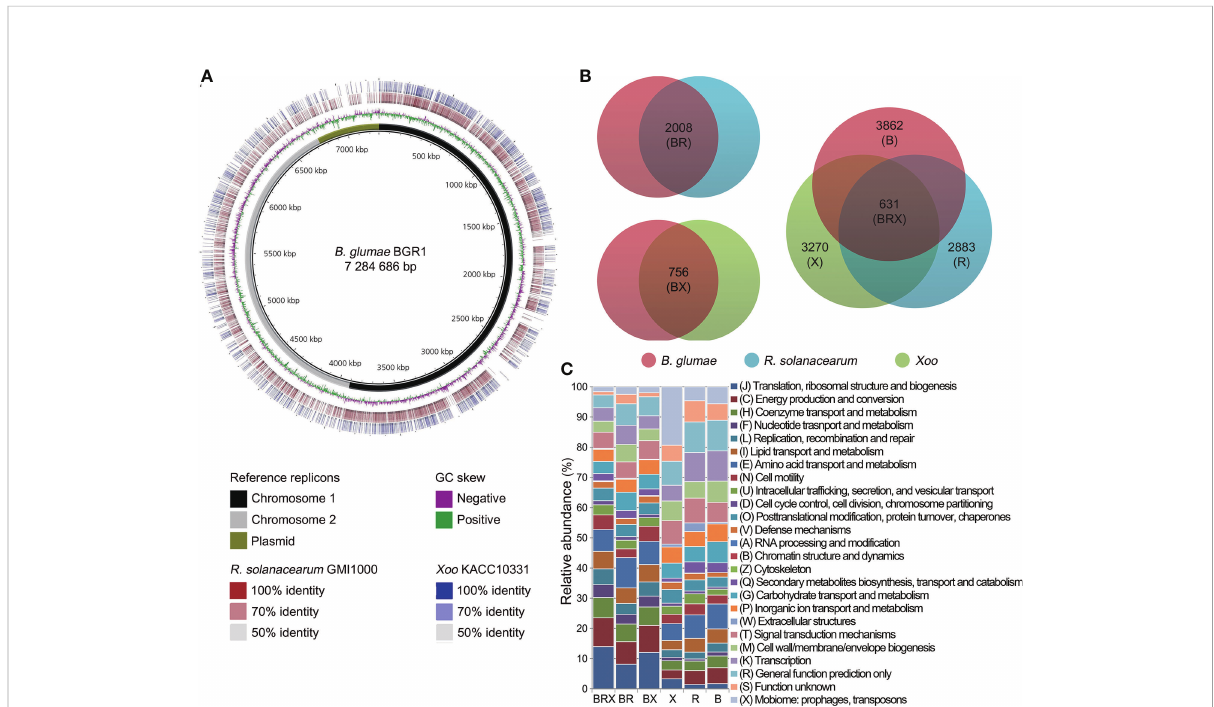
FIGURE 1 Comparative genome analysis among three pathogens (A) Multiple genome comparisons were performed using the ( B ) glumae BGR1 genome as a reference. The two innermost circles represent the reference sequence and GC skew, respectively. The reference sequence of ( B ) glumae BGR1 included three genome replicons (black, chromosome 1; grey, chromosome 2; and olive, plasmids) combined into a single contig. The outer rings illustrate the similarity of the R. solanacearum GMI1000 and Xoo KACC10331 genomes to the reference sequence. Higher color intensity represents a higher percentage of identity. (B) Venn diagram illustrating the sizes of orthologous and non-orthologous groups in the pan-genome. The genetic features of each pathogen are grouped within colored circles as follows: BR group between ( B ) glumae and R. solanacearum ; BX group between ( B ) glumae and Xoo ; BRX group among the three pathogens; and B, R, and X non-orthologous groups of each pathogen. (C) Frequencies of genes within 25 COG categories are illustrated for the orthologous and non-orthologous groups. The bar chart indicates the percentage of genes belonging to each functional category relative to the total number of genes in all COG categories. COG categories are displayed on the right side of the